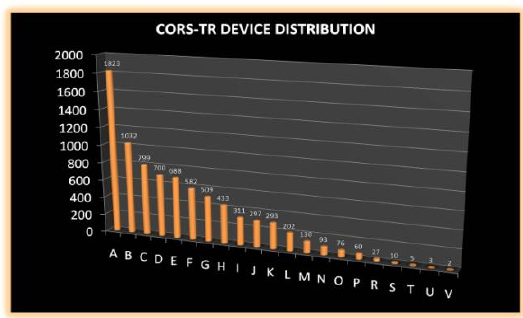
Figure 10. Subscriber to CORS-TR System by GNSS